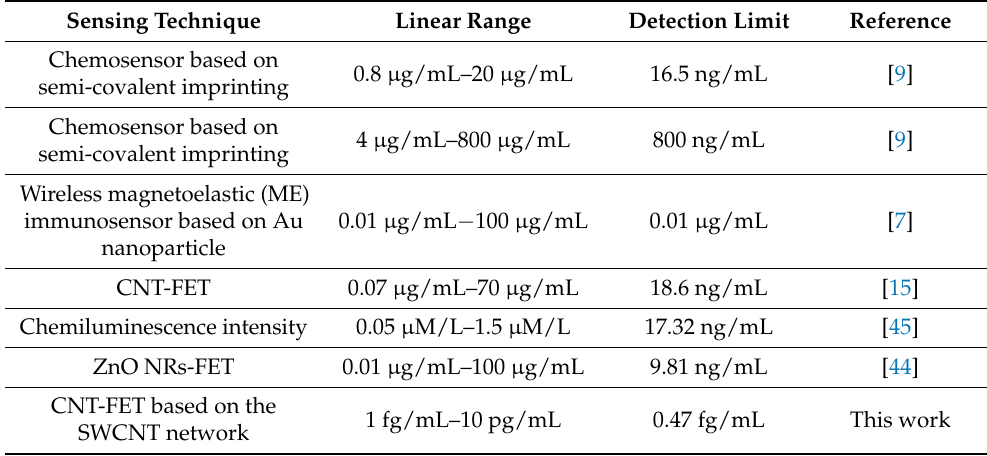
Table 1. Performance of HSA detection in this study in comparison to previous immunosensor studies.